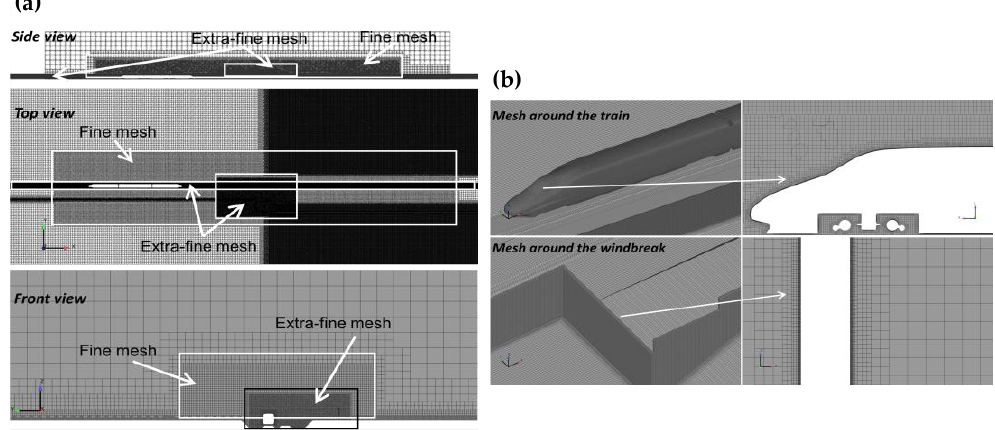
Figure 5. Computational mesh: ( a ) different views and ( b ) the mesh around the model and the surface layer mesh. Table 1. Details of the different grid resolutions.